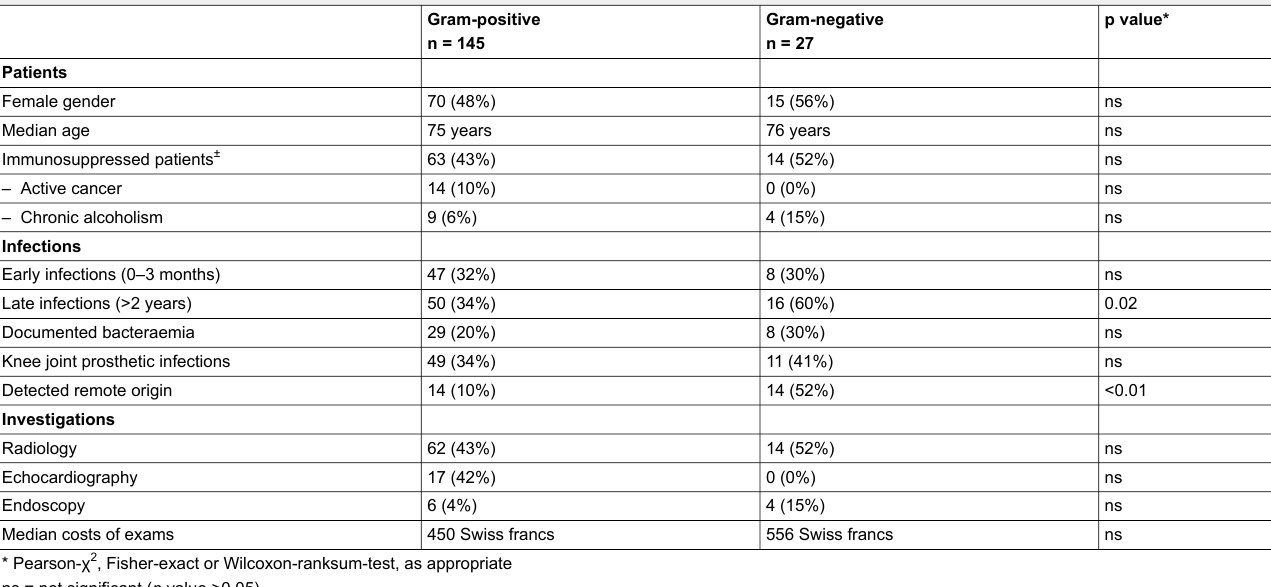
Table 1: Gram-positive versus Gram-negative prosthetic joint